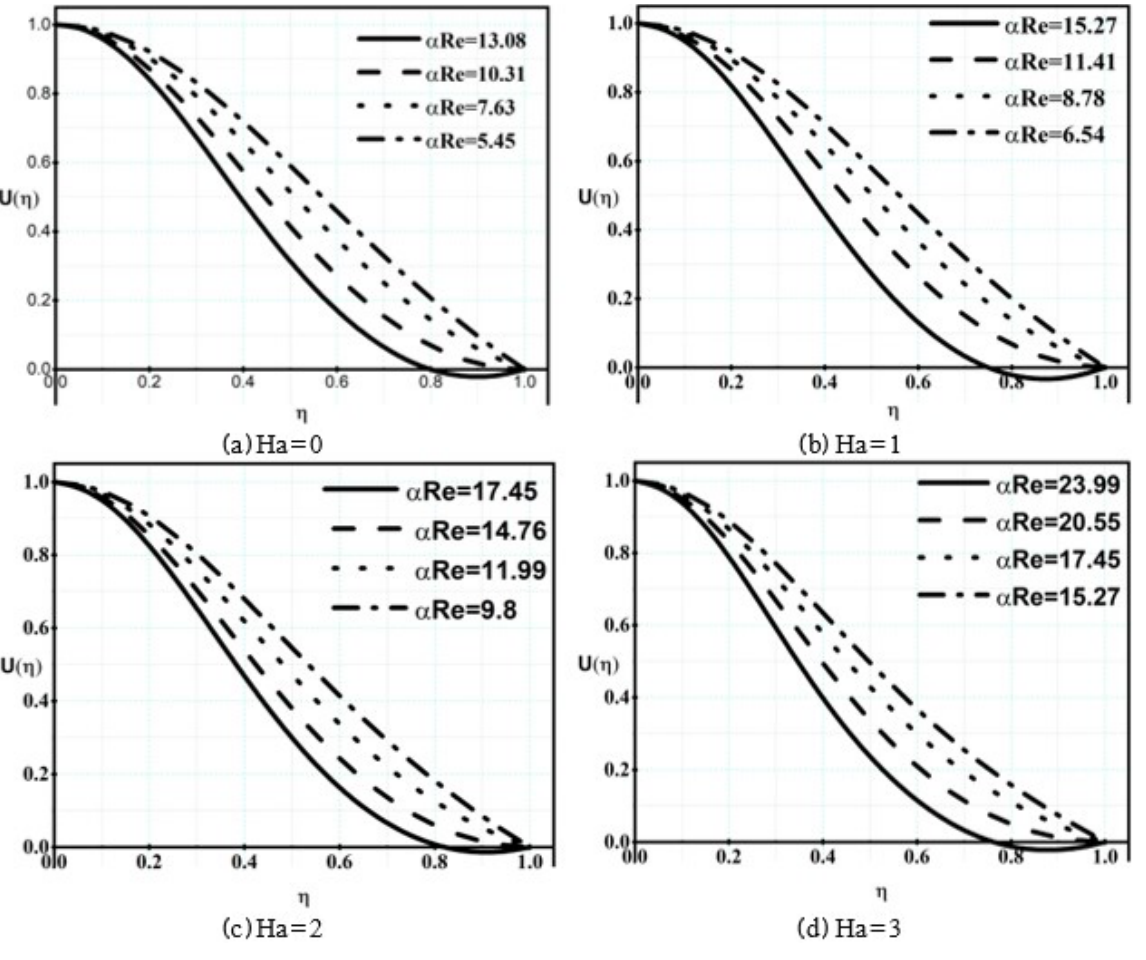
Figure 5. Hartmann number effect on the dimensionless velocity distribution.